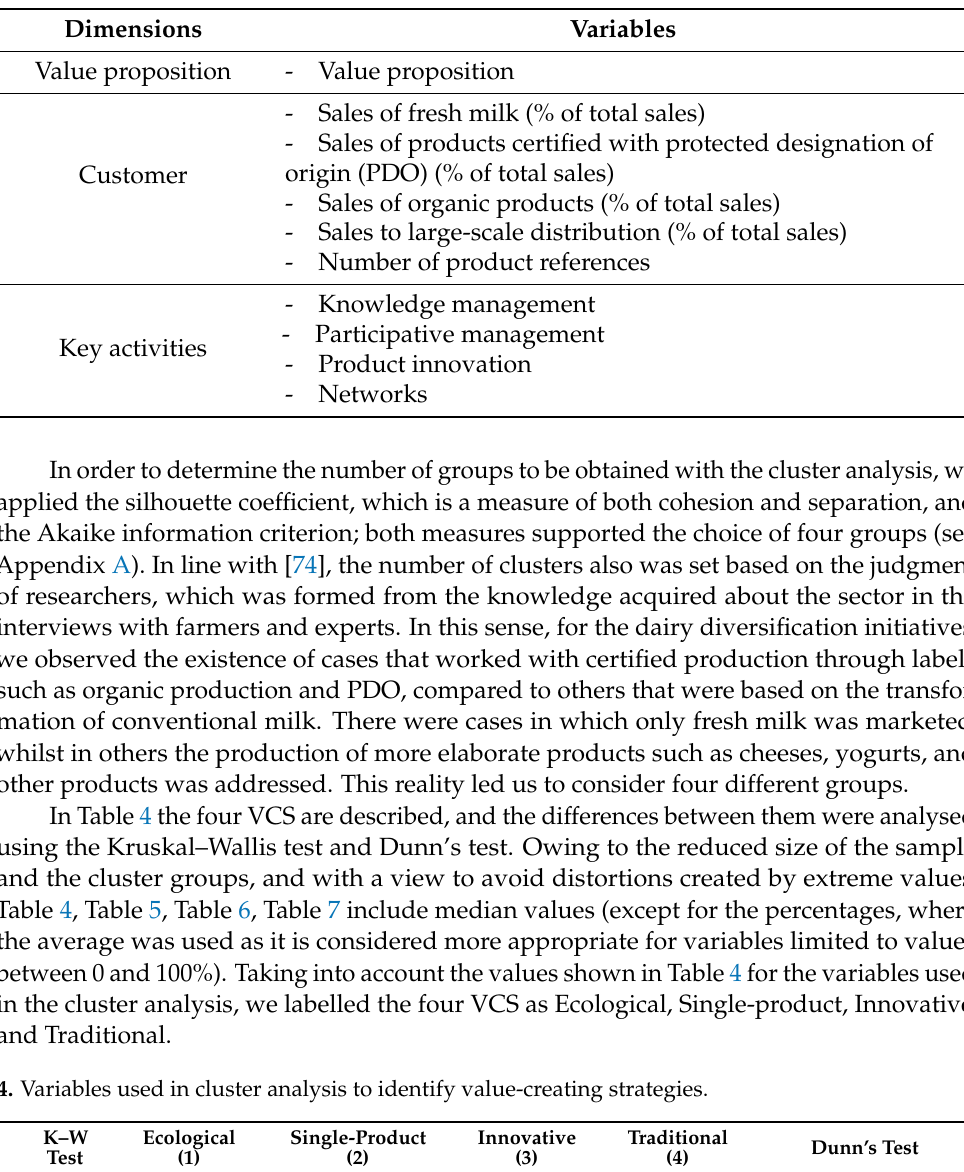
Table 3. Dimensions and variables of the structure proposed for the analysis.